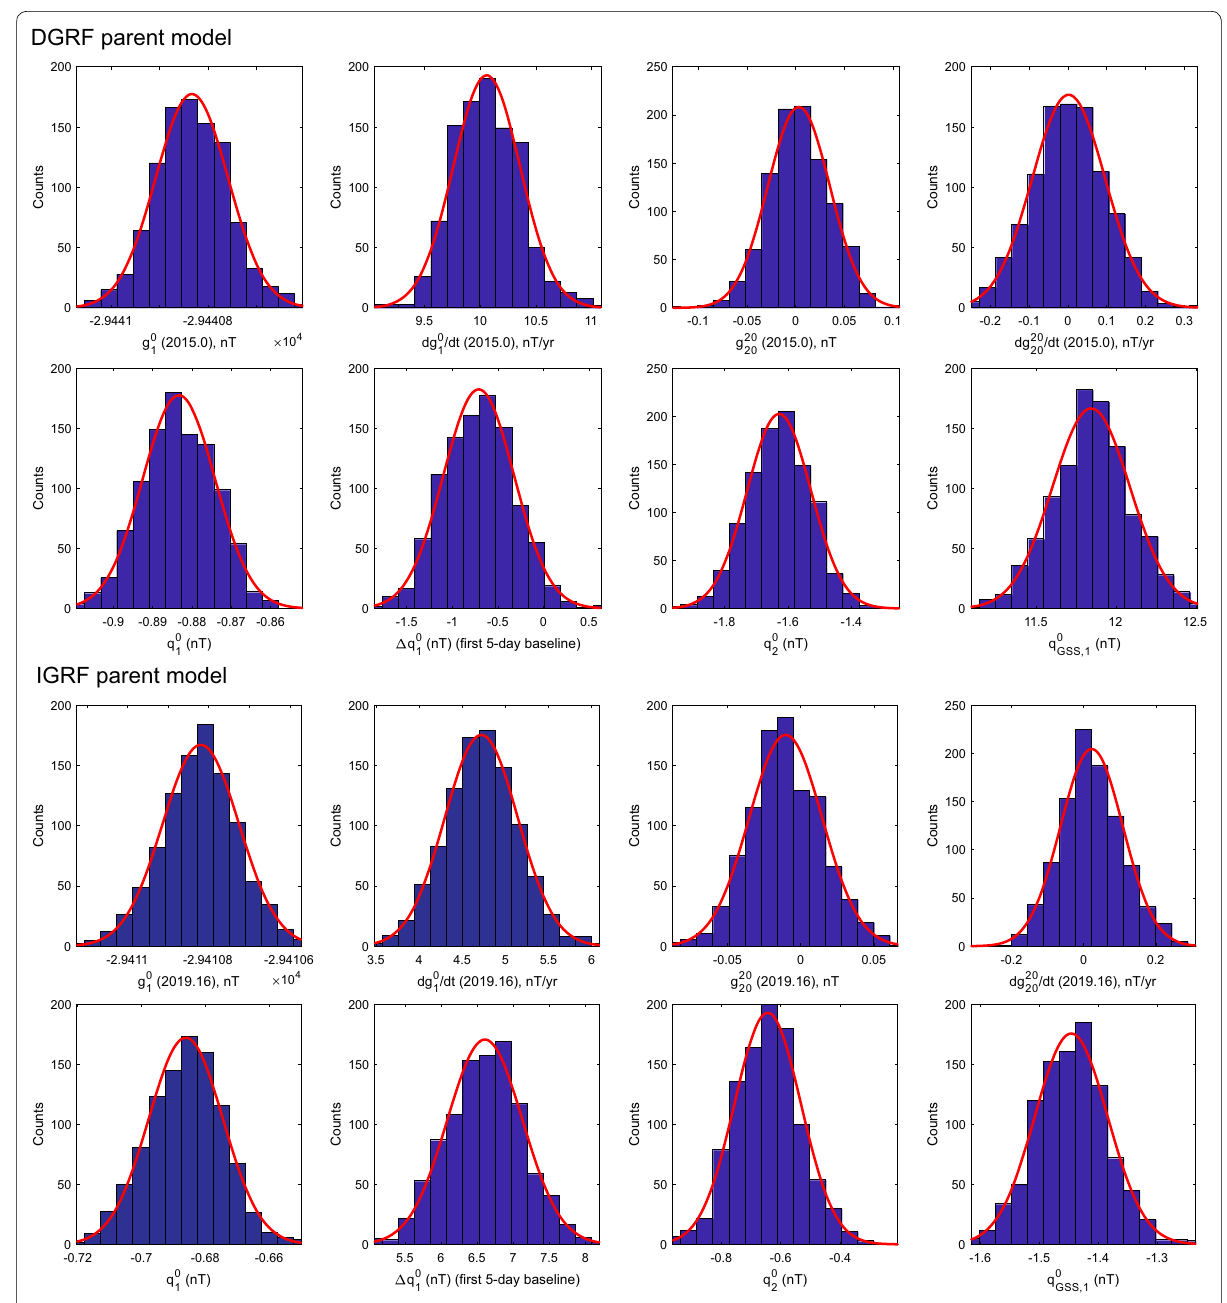
Fig. 5 Some Gauss coefficients and baseline corrections for both (upper panel) DGRF and (lower panel) IGRF parent models. Red lines show theoretical Gaussian distribution calculated from the mean and the standard deviation of the